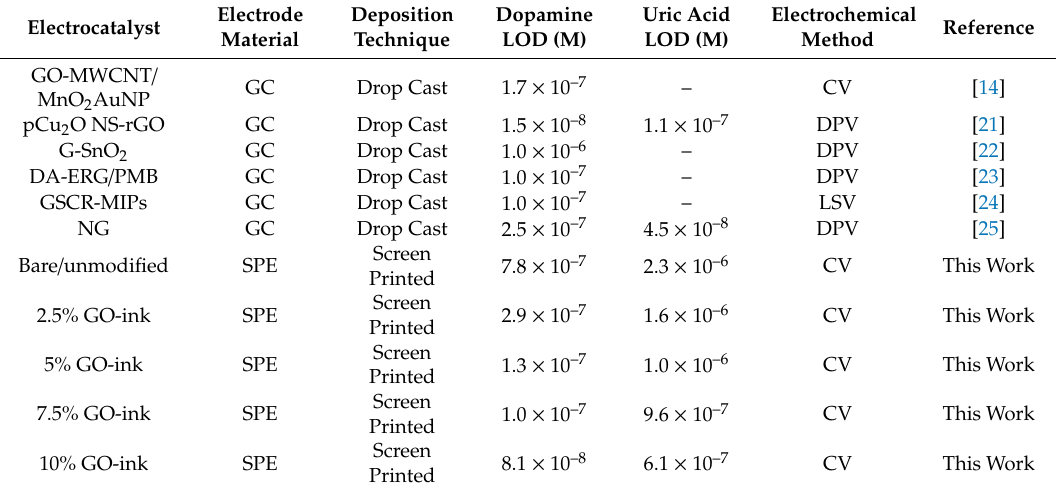
Table 1. Comparison of current literature reporting the use of graphene and related electrocatalytic materials explored towards the electroanalytical sensing of dopamine (DA) and uric acid